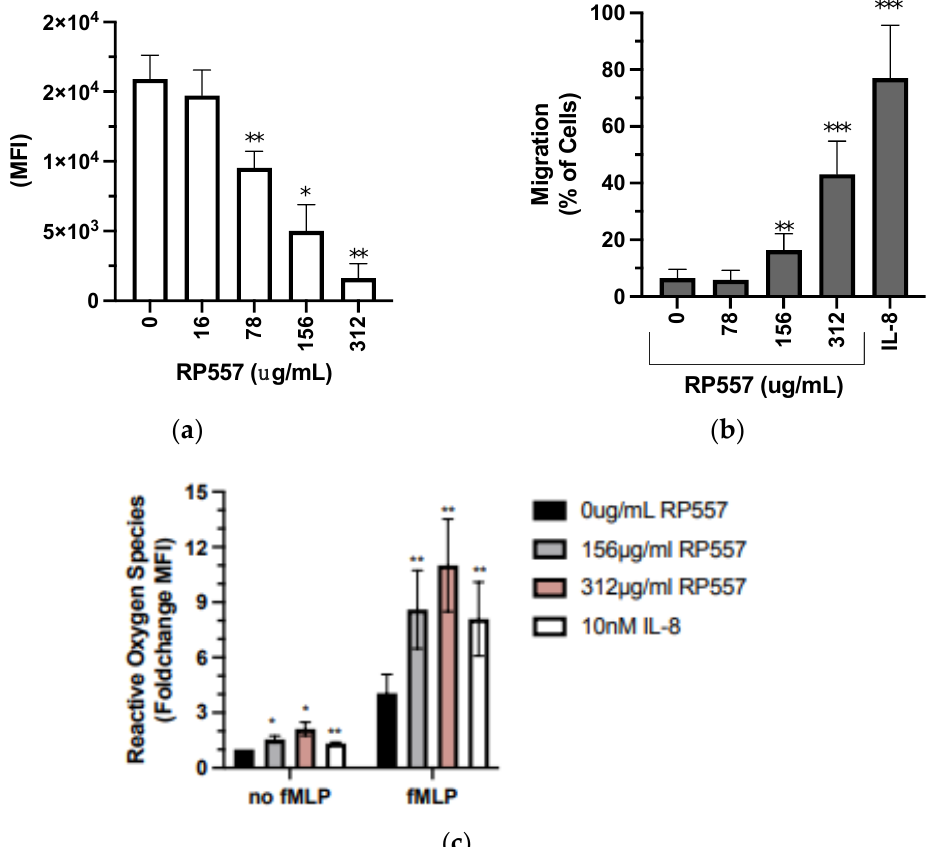
Figure 2. RP557 altered neutrophil effector function. ( a ) Isolated human neutrophils were incubated with varying concentrations of RP557 for 20 min at 37 °C, washed, and stained with antibodies for 15 min at 37 °C, followed by fixation and quantification by flow cytometry of CD62L expression on the cell surface. The data are presented as the mean fluorescence intensity ± SEM ( n = 3 donors) with experimental replicates averaged for each donor. Paired t -tests were performed comparing the average value of the experimental condition to the 0 µ g/mL control condition of the same donor. ( b ) Percent of neutrophils that migrated through an uncoated polycarbonate transwell insert in response to varying concentrations of RP557, Il-8 (10 nM), or vehicle control over a 2 h period ( n = 3–5 per group). ( c ) Fold change in fluorescence over 0 µ g/mL in neutrophils stained with 2 µ M of the reactive oxygen species indicator DHR 123 and treated with RP557, IL-8, or vehicle control for 10 min before addition of 1 µ M fMLP or vehicle control for 5 min. A paired ratio t -test was performed comparing the average value for an experimental condition to the untreated condition of the same donor. RP557 has a molecular weight of 2135.69 amu. MFI: mean fluorescence intensity. *, **, *** denote p - value ≤ 0.05 ≤0.01, and ≤0.001 , respectively.